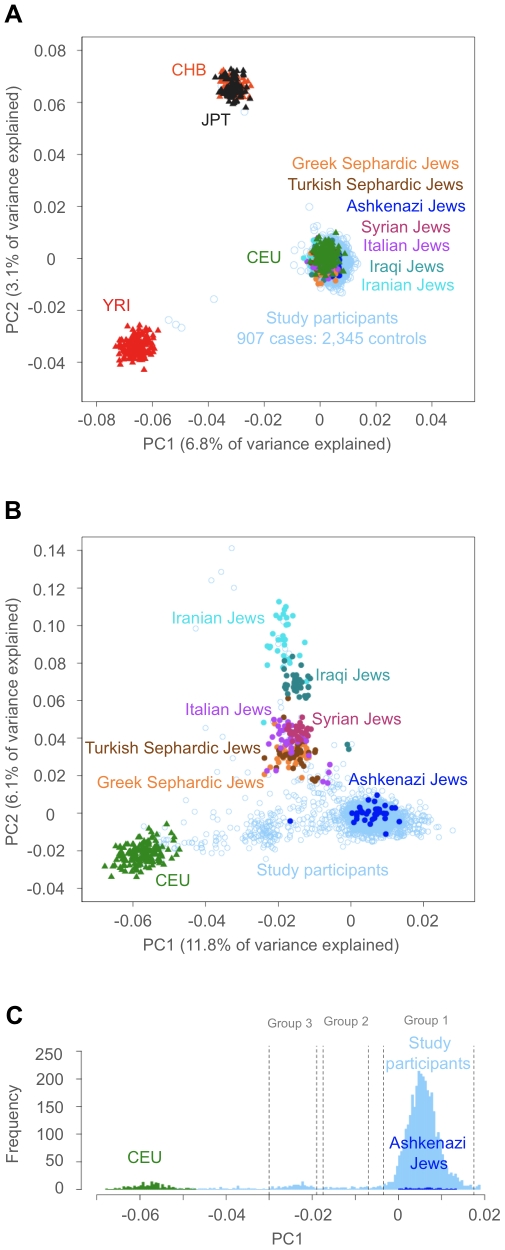
PCA analysis of the study participants.(A) PCA showing the first (X-axis) and second (Y-axis) eigenvectors plotting all 3,252 study participants (907 CD cases and 2,345 controls) across ∼22 K unlinked SNPs indicated by light blue open circles. Also included and color-coded in the graph are the four HapMap (www.hapmap.org) reference samples as solid triangles; CEPH-Utah (CEU; green), Yoruban-Nigeria (YRI; red), Han Chinese (CHB; orange) and Japanese (JPT; dark grey); and seven Jewish samples from the Jewish Hapmap project [2] as solid circles, consisting of Ashkenazi Jews (AJ; blue), one European (Italian; purple), three Middle Eastern (Syrian; fuchsia, Iraqi; teal and Iranian; turquoise) and two Sephardic Jewish cohorts (Turkey; brown and Greek; orange). (B) The same analysis excluding the YRI and CHB+JPT reference panels. (C) A histogram of PC1 values for study participants (light blue) near the AJ cluster and intermediate between the AJ and CEU clusters. The histogram of PC1 values for the included samples show three distinct modes (Groups 1–3), with AJ reference (blue) and CEU (green) indicated.